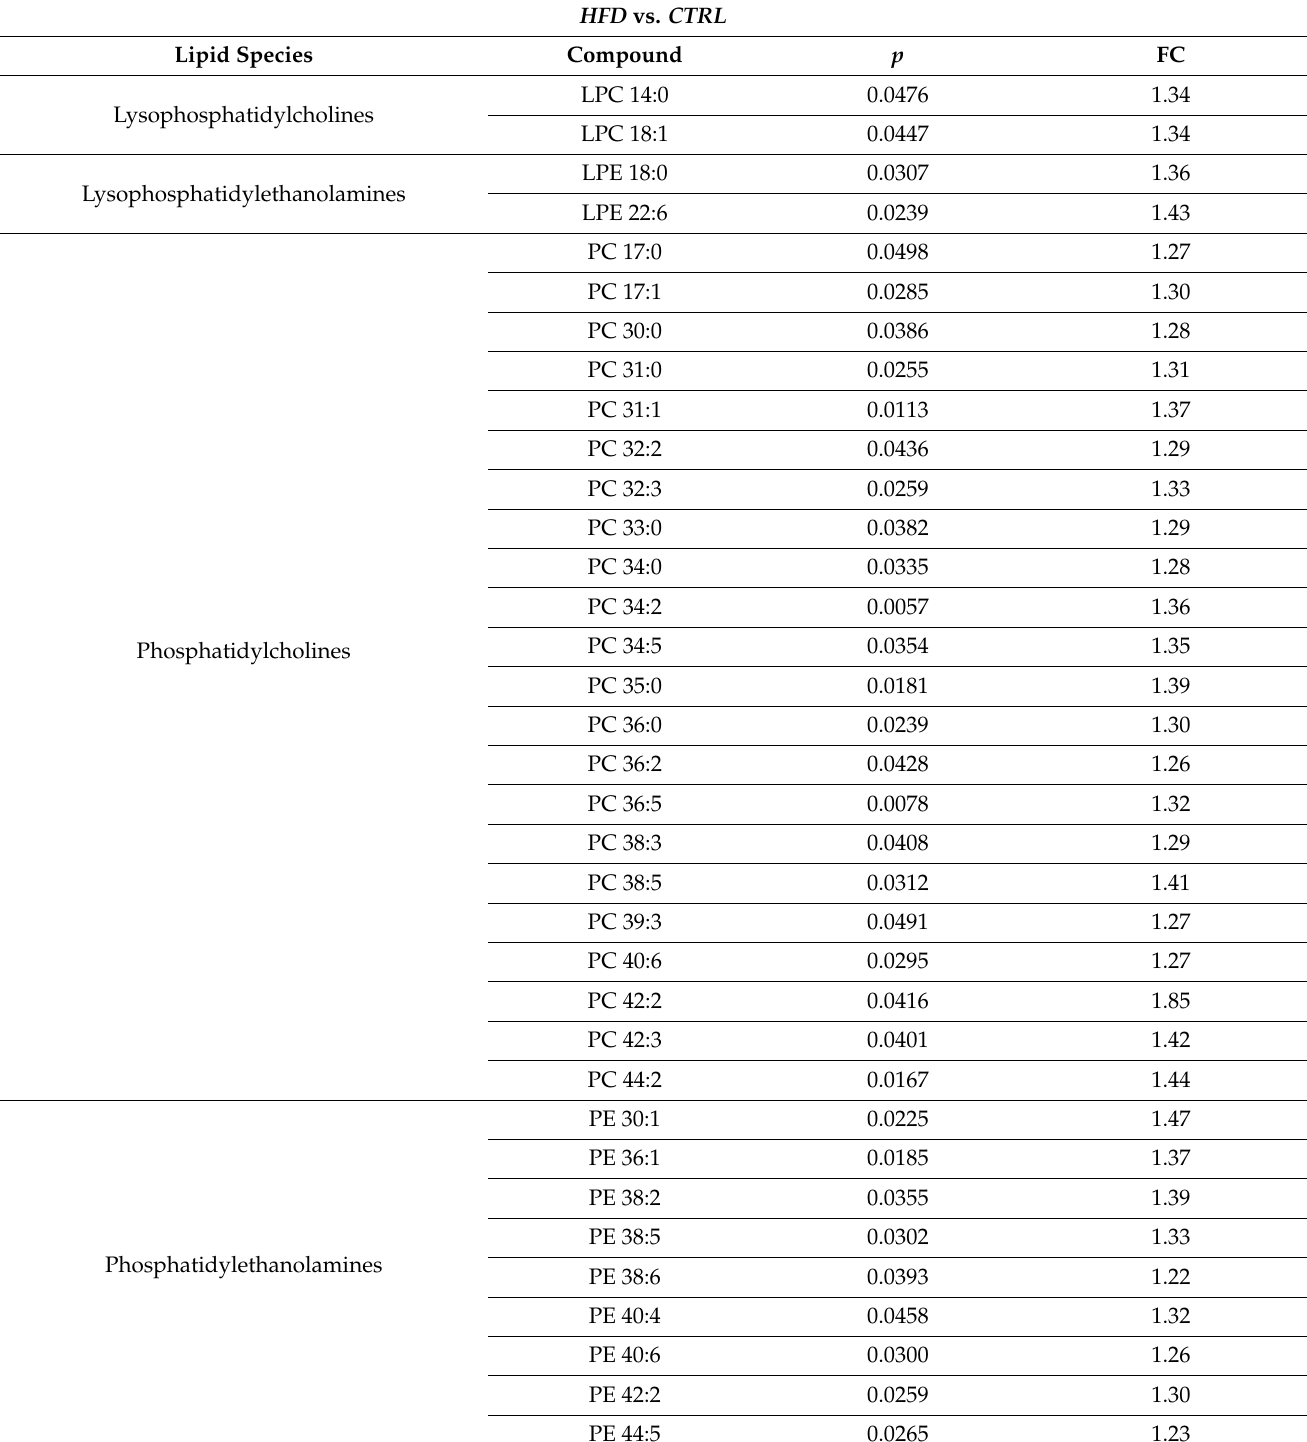
Table 4. Statistically significant differences in brain lipids by week 12 in the three different pairs of conditions. FC, fold